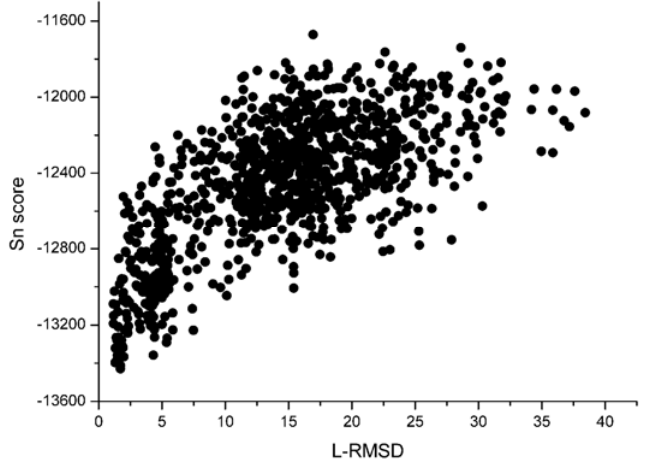
Figure 3. The correlation between the L_RMSD and the Sn scoring function (The 1udi was taken as an illustration).